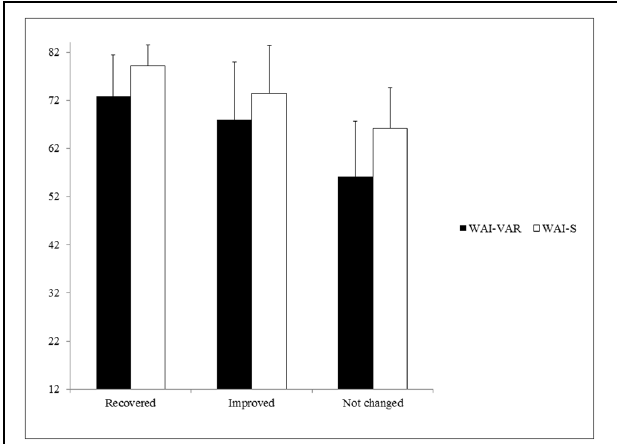
FIGURE 1 | Results on the WAI-VAR and WAI-S of the “recovered,” “improved,” and “not changed” patients. Mean ( M ) and Standard Deviation ( SD ) on the WAI-VAR and WAI-S of the “recovered,” “improved,” and “not changed” patients. WAI-S = Mean and Standard Deviation on the Working Alliance Inventory-Short Form of the “recovered,” “improved,” and “not changed” patients; WAI-VAR = Mean and Standard Deviation on the Working Alliance Inventory applied to Virtual and Augmented Reality of the “recovered,” “improved,” and “not changed”